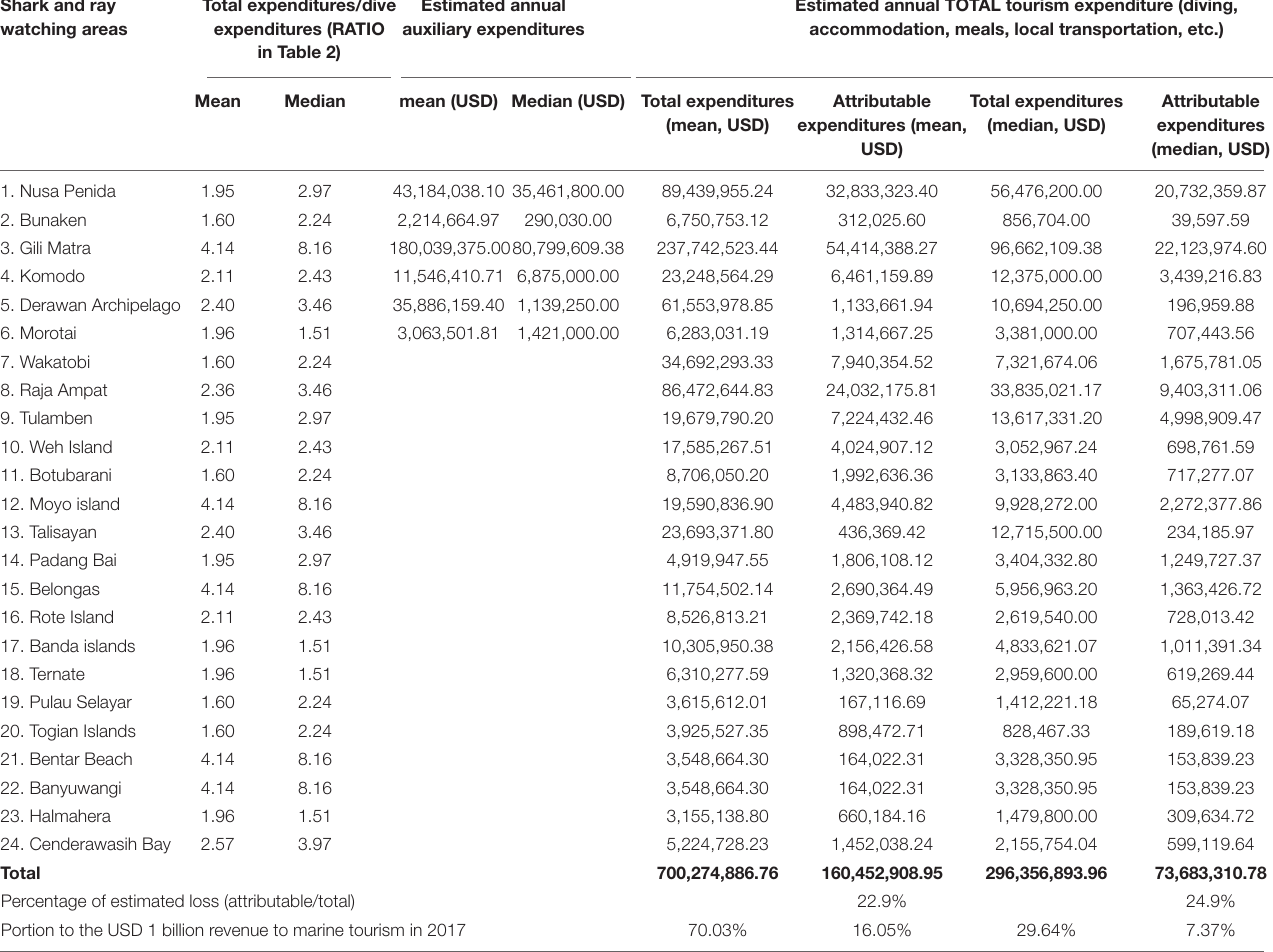
TABLE 4C | Estimated annual shark and ray expenditures (USD) for 235 dive operators in Indonesia. Shark and ray watching areas